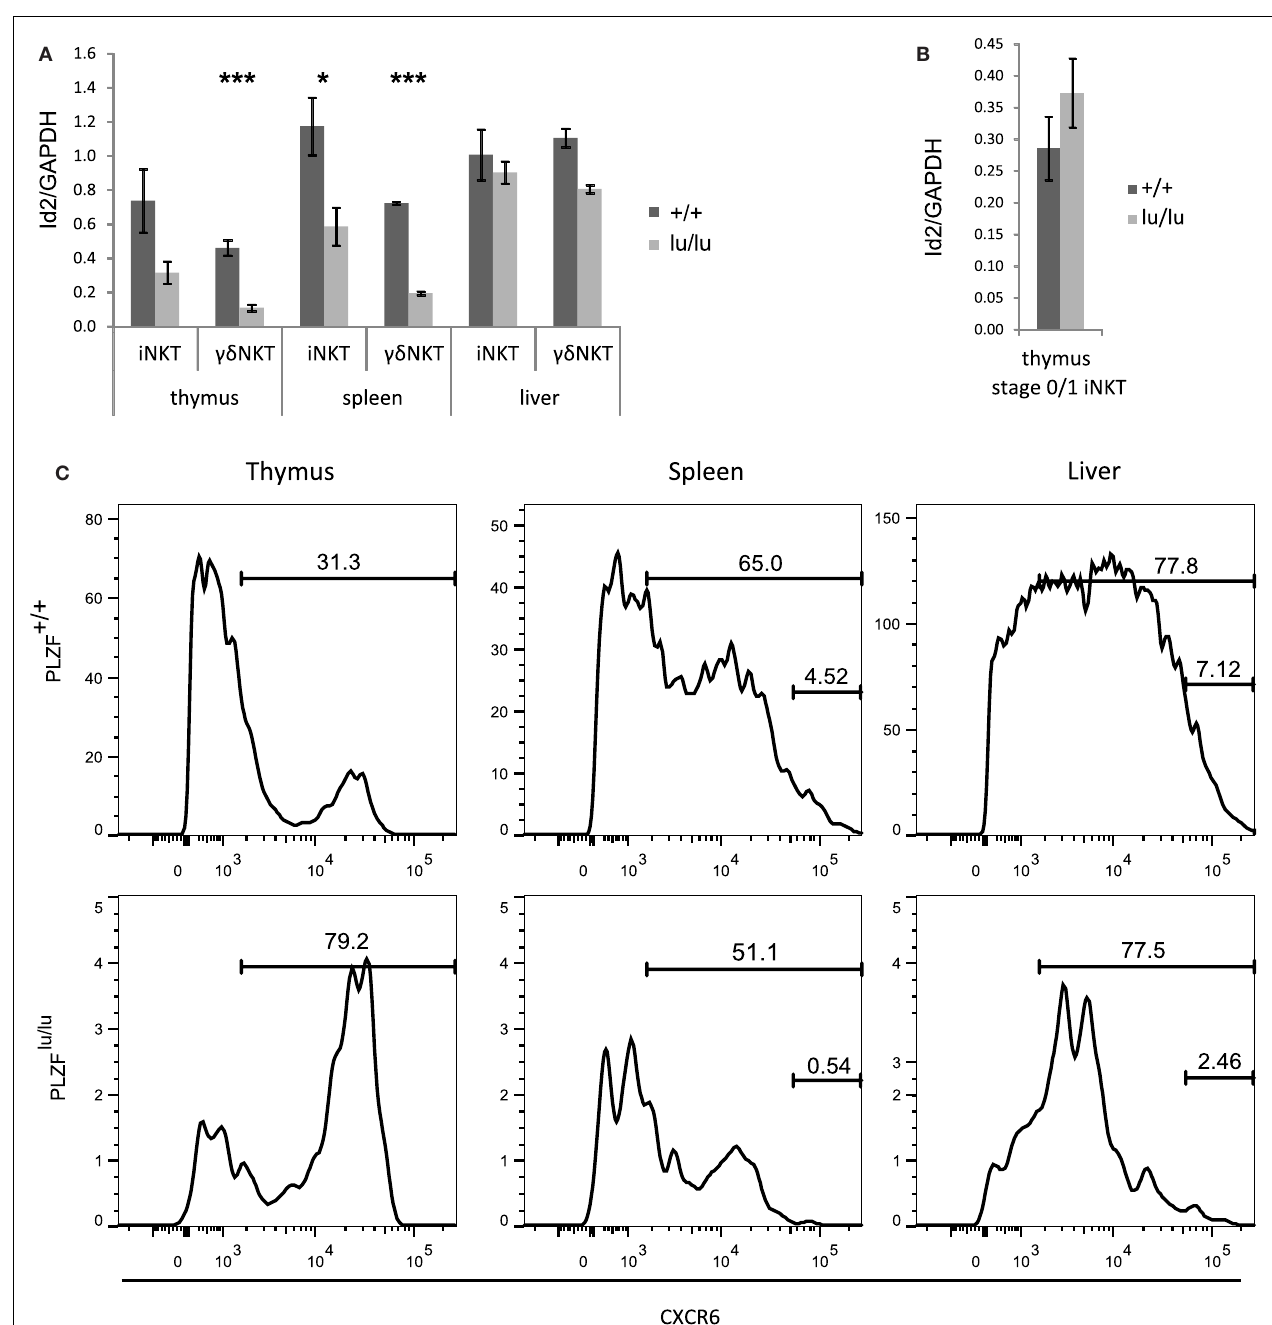
expression is shown. Error bars represent SD (individual mice). Statistical significance is shown where reached. (C) CXCR6 expression was analyzed on wt (CD45.1) or PLZF lu/lu (CD45.2) iNKT (TCR β + CD1d-Tet + ) cells from the thymus, spleen, and liver of bm chimeric mice. Percent CXCR + and CXCR hi are